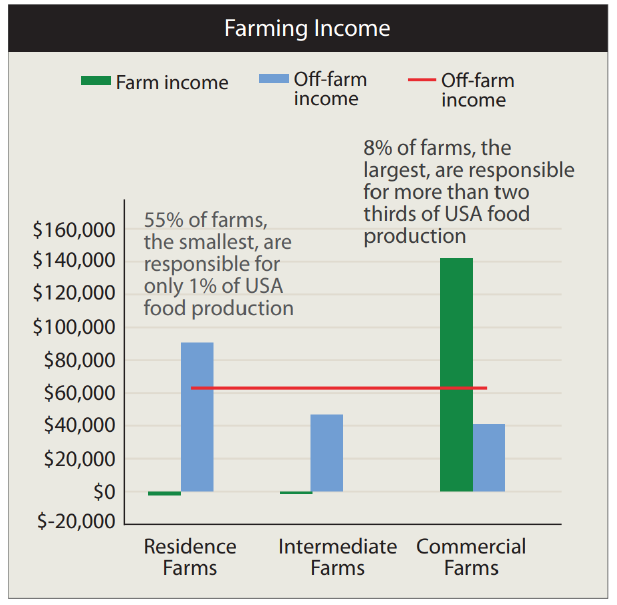
Figure 1. Old McDonald is Struggling Although family farmers represent the majority of farmers in the U.S., they are increasingly unable to profit from and live off their farms (Klein & Locke,